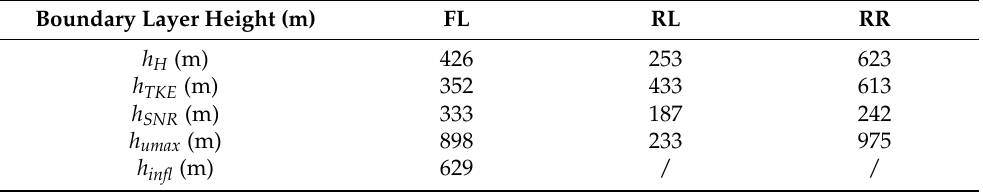
Table 4. Mean values of BLHs when S_1 is in different quadrants of the typhoon center.